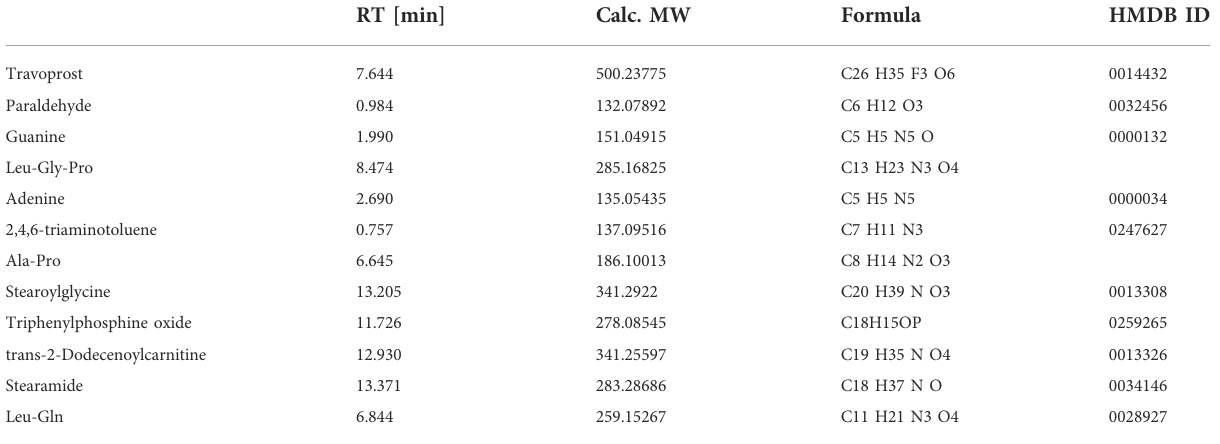
TABLE 2 Identi fi ed potential biomarkers regulated by TFPS treatment.